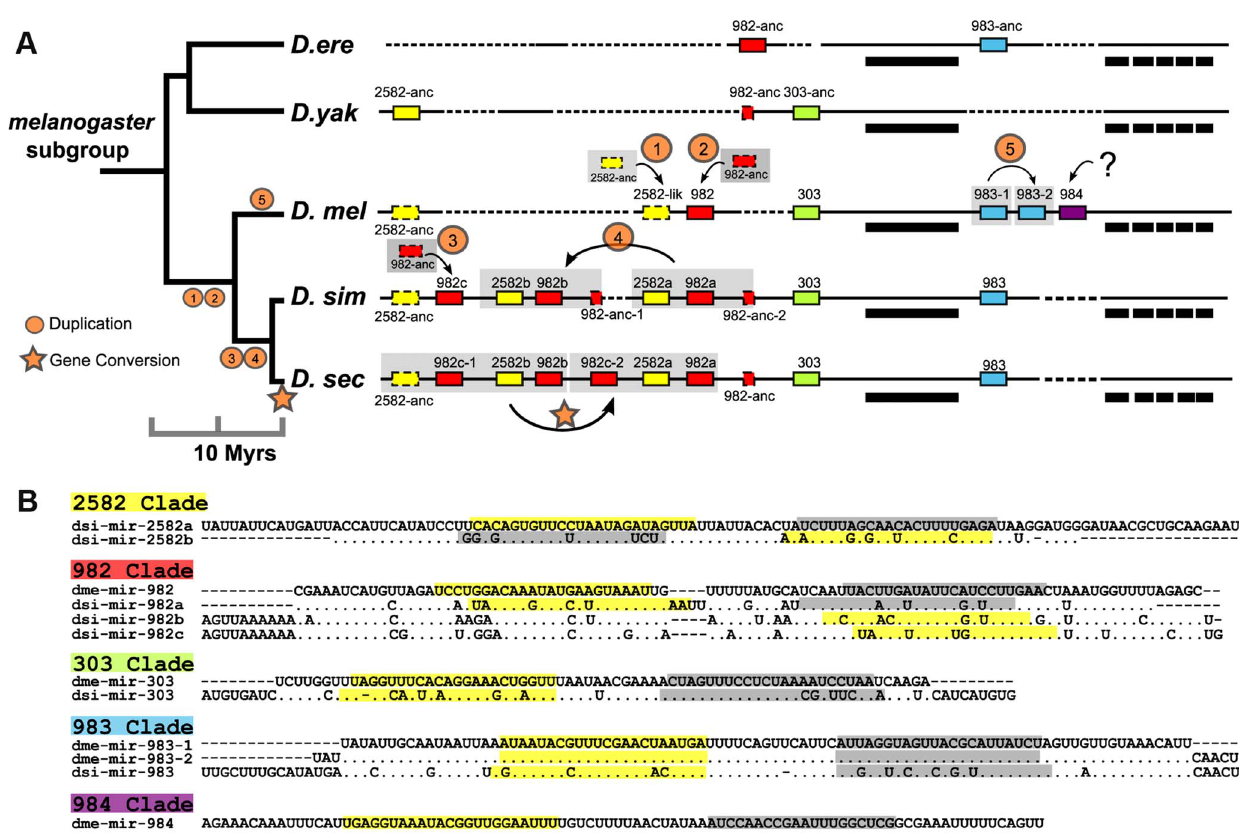
Figure 2. The evolution of the structure of the miR-982s cluster. ( A ) This cluster comprises members of five miRNA families (miR-982, miR- 2582, miR-303, miR-983 and miR-984), indicated by red, yellow, green, blue and purple boxes, respectively. Boxes outlined with solid and dashed lines represent miRNA homologs with and without expression, respectively. Bold bars indicate CG3626 exons 1–6 located on the opposite strand of miR- 982s. Alignment gaps are illustrated with dashed lines. The genomic region is not drawn to scale. Species abbreviations: D. ere , D. erecta ; D. yak , D. yakuba ; D. mel , D. melanogaster ; D. sim , D. simulans ; D. sec , D. sechellia . ( B ) Precursor sequences of miRNAs from the miR-982s cluster. Mature (miR) and miR* sequences are indicated in yellow and gray, respectively. When there is no annotation of miR* in the database, we define miR* as starting with 1 nt 3 9 overhangs on the opposite arm of miR.